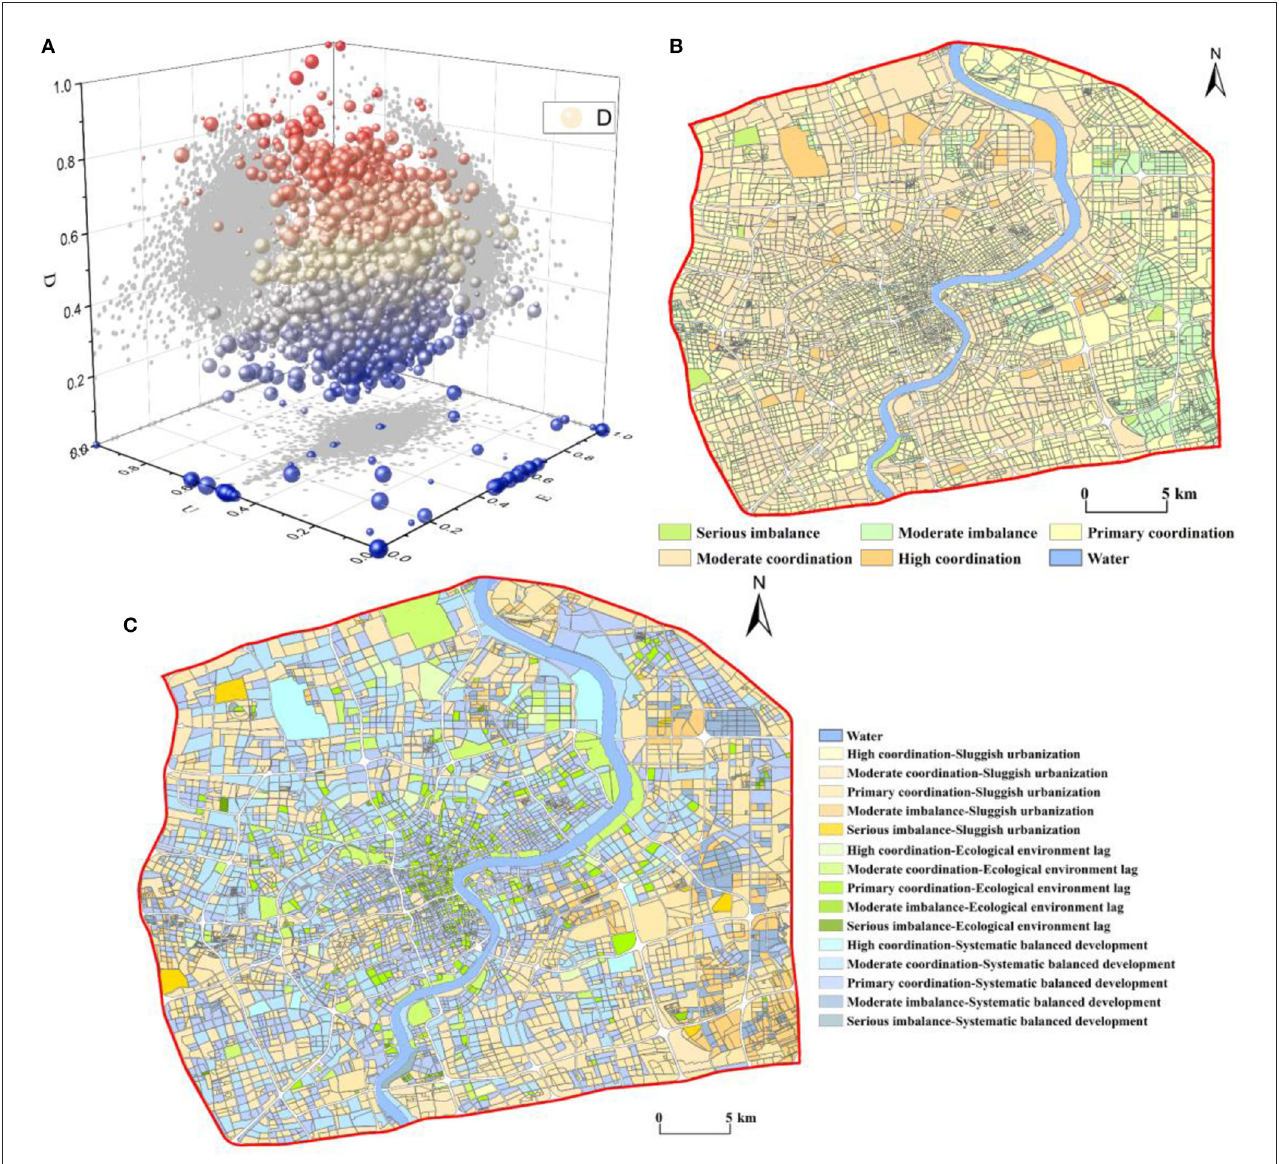
FIGURE4 Spatial pattern of the D in central Shanghai (A) 3D scatter plot of D, (B) classes of D, and (C) coupling coordination